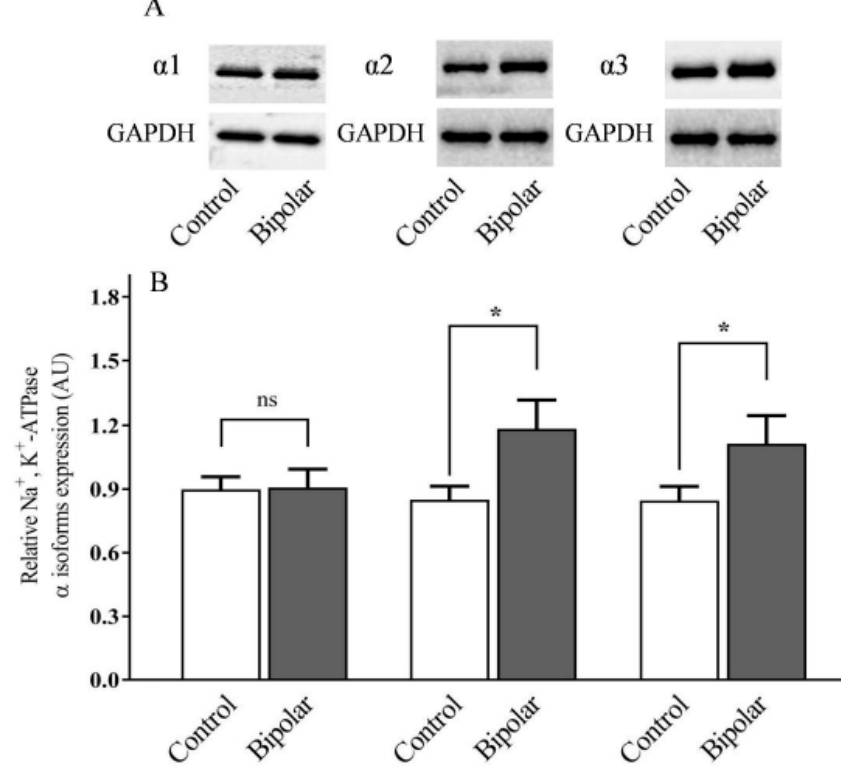
Figure 1. Na + , K + ATPase α isoform expression in PFC of BD patients and controls. Na + , K + -ATPase α subunit isoform expression in postmortem prefrontal cortex samples of controls and BD patients ( n = 20 per group) was determined by Western blot analysis, as described in the materials and methods. ( A ): Representative Western blots. ( B ): Quantitative isoform expression. The values were normalized to glyceraldehyde 3-phosphate dehydrogenase (GAPDH). The bars represent the means; the error bars represent the standard error of the means; * di ff er from the control group p < 0.05; ns: